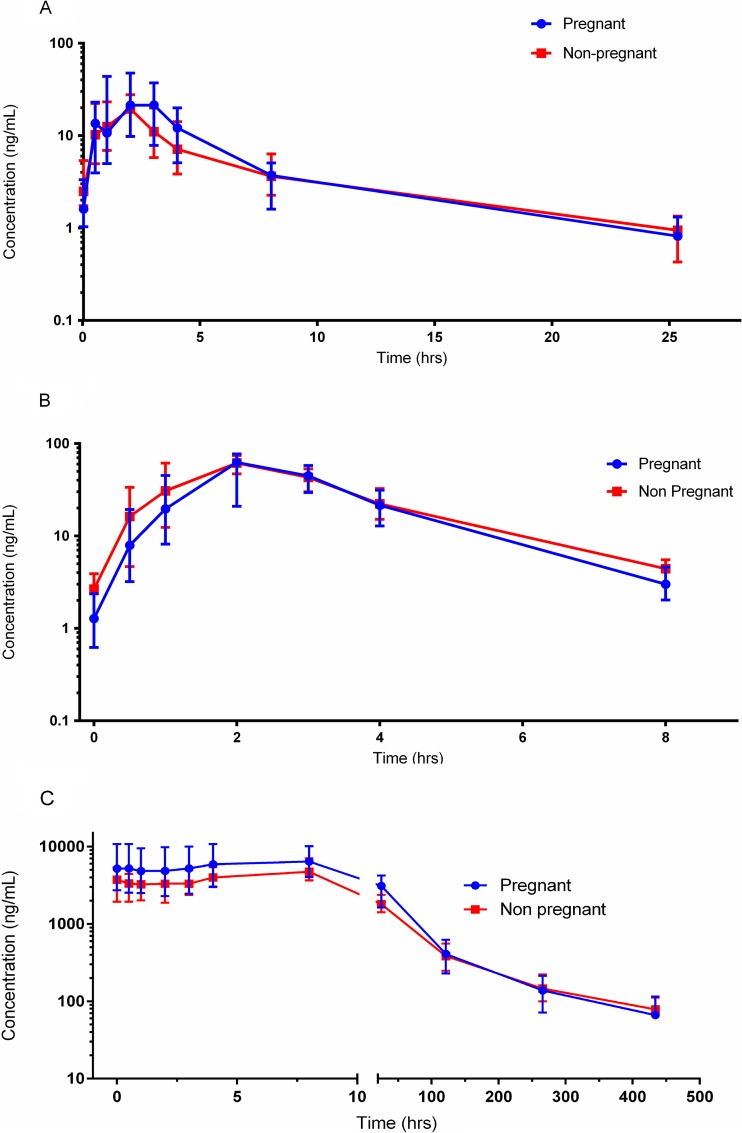
Time-plasma concentration plot of artemether (A), dihydroartemisinin (B), and lumefantrine (C) in pregnant women and nonpregnant adults with uncomplicated malaria. The median concentrations are reported, with the error bars indicating interquartile ranges.